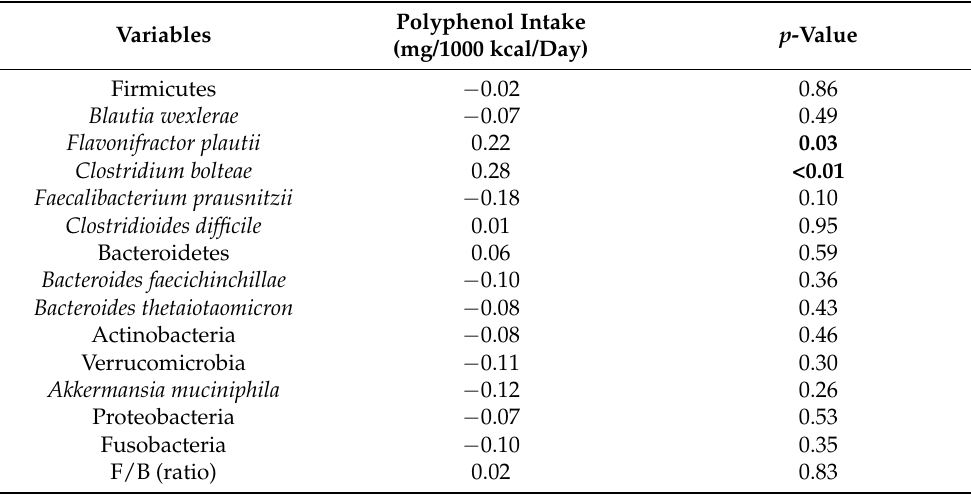
Table 2. Correlations between gut microbiota and polyphenol intake, n = 92.